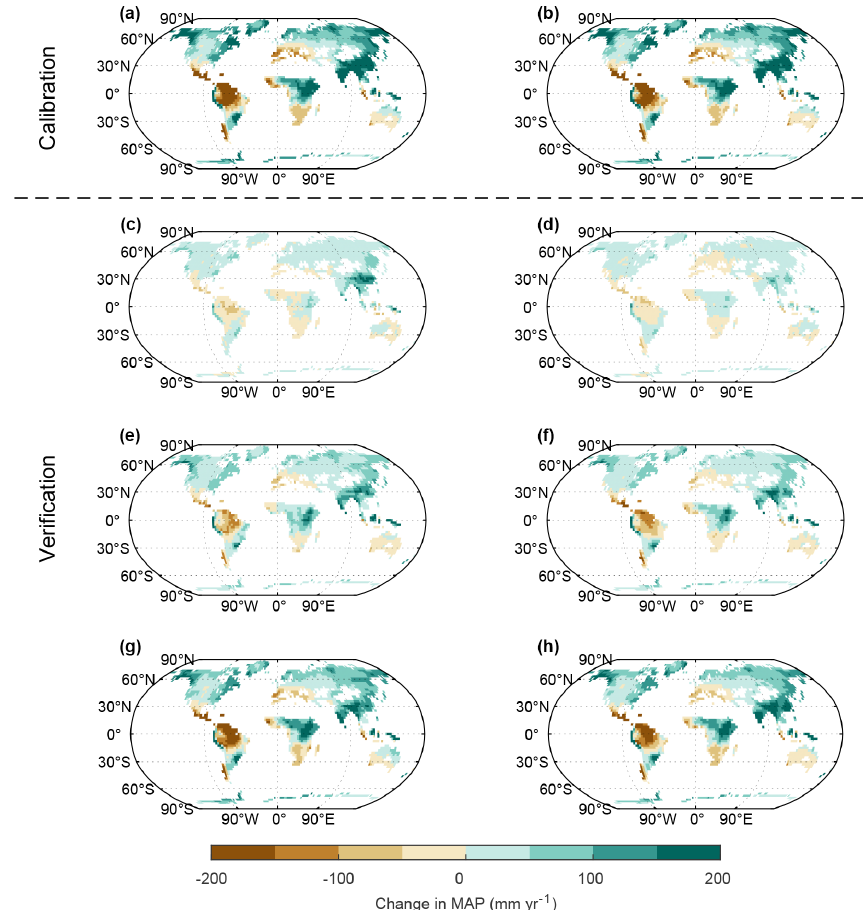
Figure 8. The spatial pattern of change in MAP in 2071–2100 from (a) multi-model mean of ESMs and (b) emulation from PREMU under SSP5–8.5 scenario. (c, d) SSP1–2.6; (e, f) SSP2–4.5; (g, h)